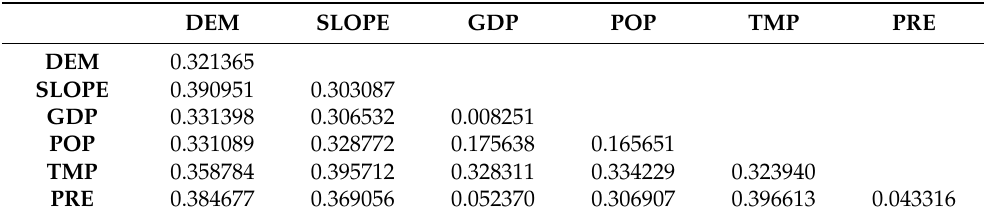
Table A9. The force (q-value) among any two influencing factors on Edge density (ED) interactively in 2020.